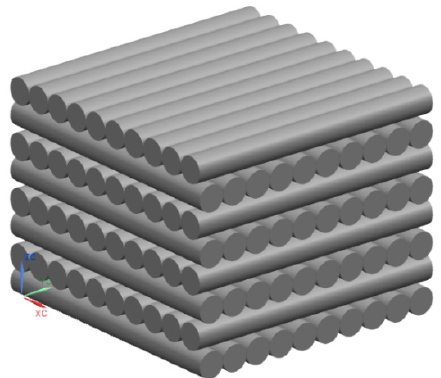
Figure 1. The schematic structure of ultra-high-molecular-weight polyethylene (UHMWPE) laminate.